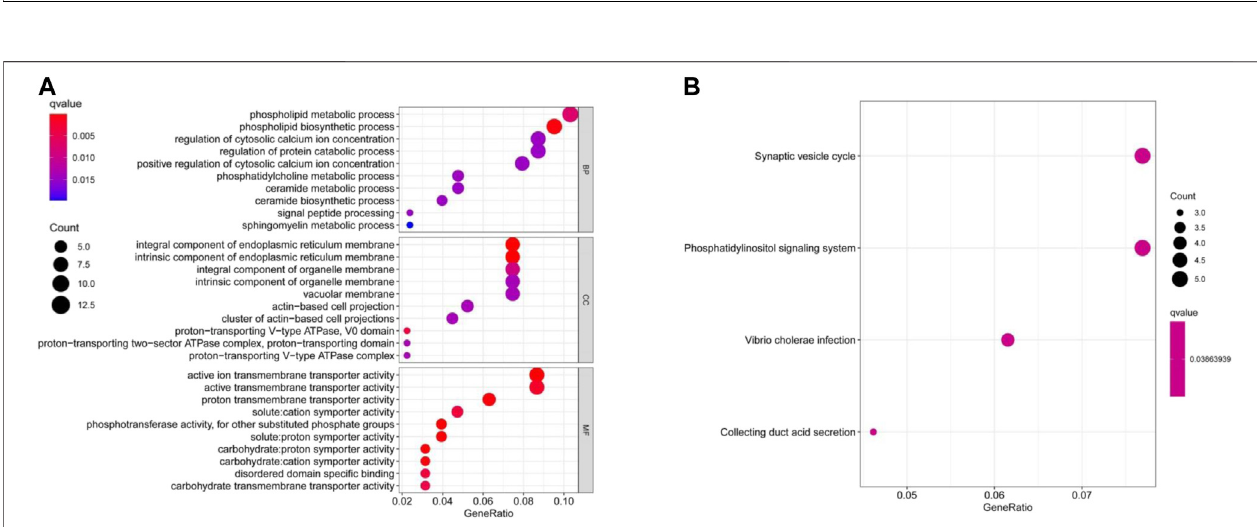
FIGURE 7 | AQP4-related gene enrichment analysis. (A) GO analysis depicts molecular functional data of potential genes that may interact with AQP4 (B) KEGG analysis was also conducted.